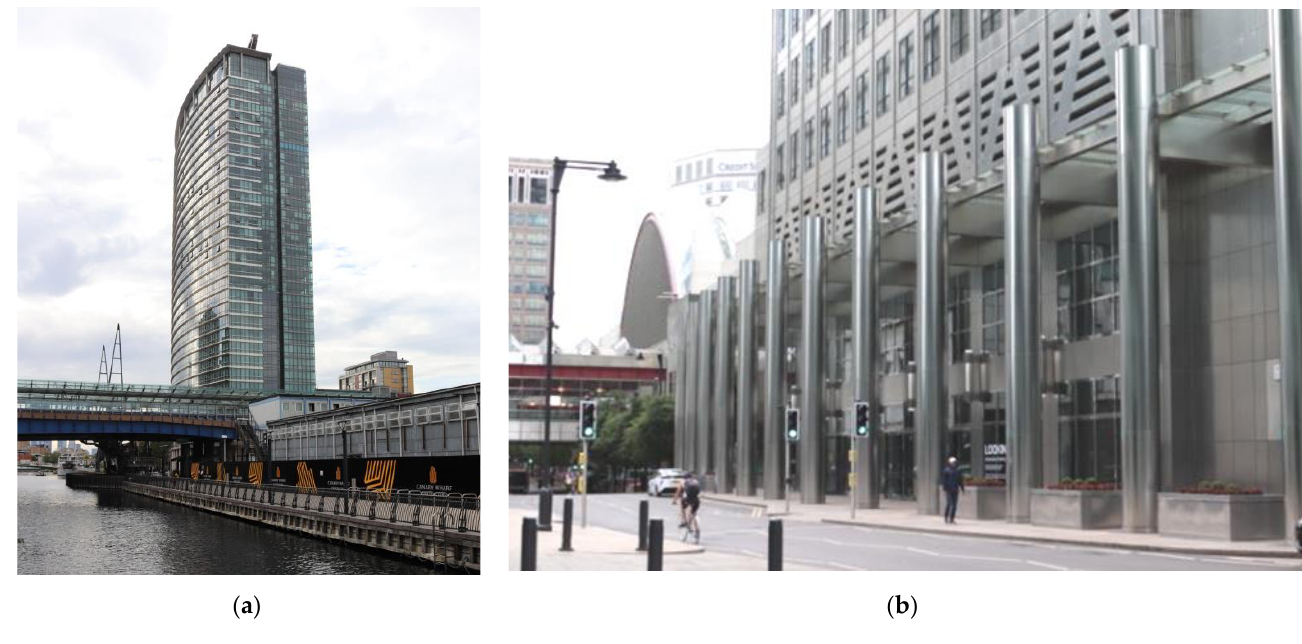
Figure 5. Different reflectivity properties emphasize architectural detailing ( a ) design of serviced apartments at 22 Hertsmere Road in the same style as office buildings, steel horizontal banding highlighted in daylight as lighter on eastern and as darker on southern elevation in contrast to glass rainscreen (2020); ( b ) The Southern frontage of One Canada Square with post-modern steel detailing appearing as different colour from the building walls made from the very same steel (2020).